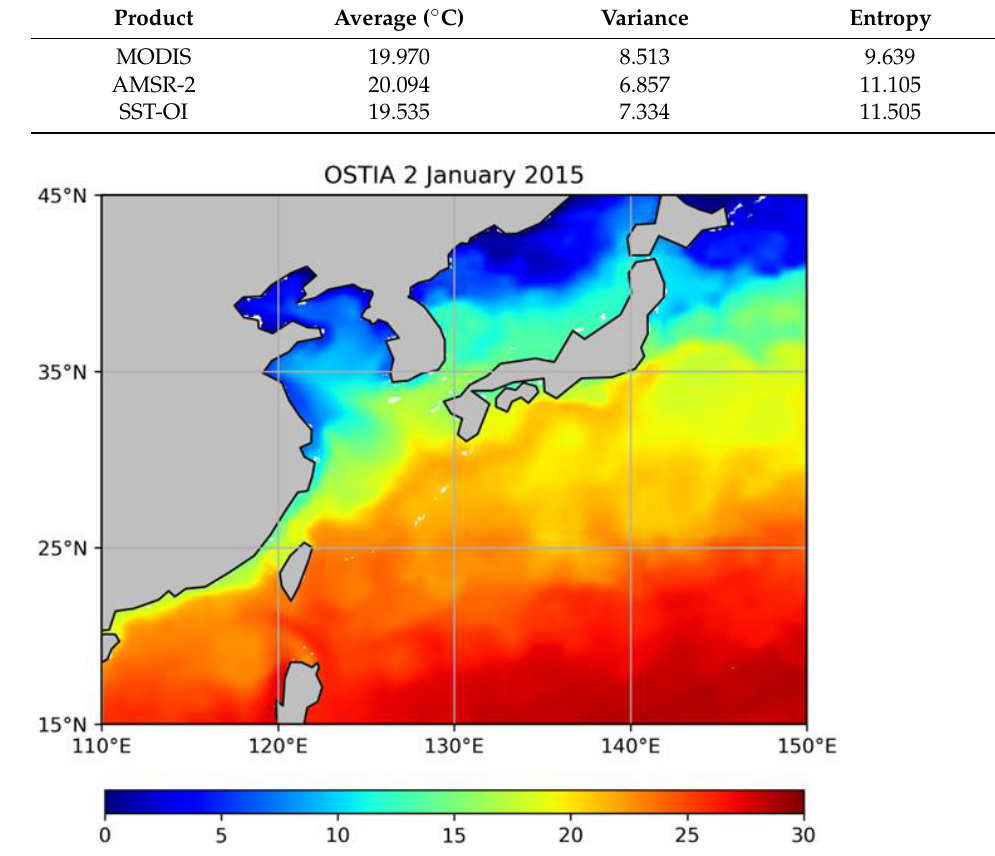
Figure 5. SST fusion result for 2 January 2015 using the OI (SST, colored shading; °C). Table 1. Comparison of MODIS, AMSR-2. and OI Fusion SST Data Quality Parameters.